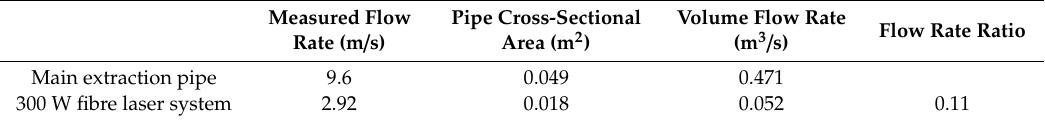
Table 4. Flow rate ratio calculations.